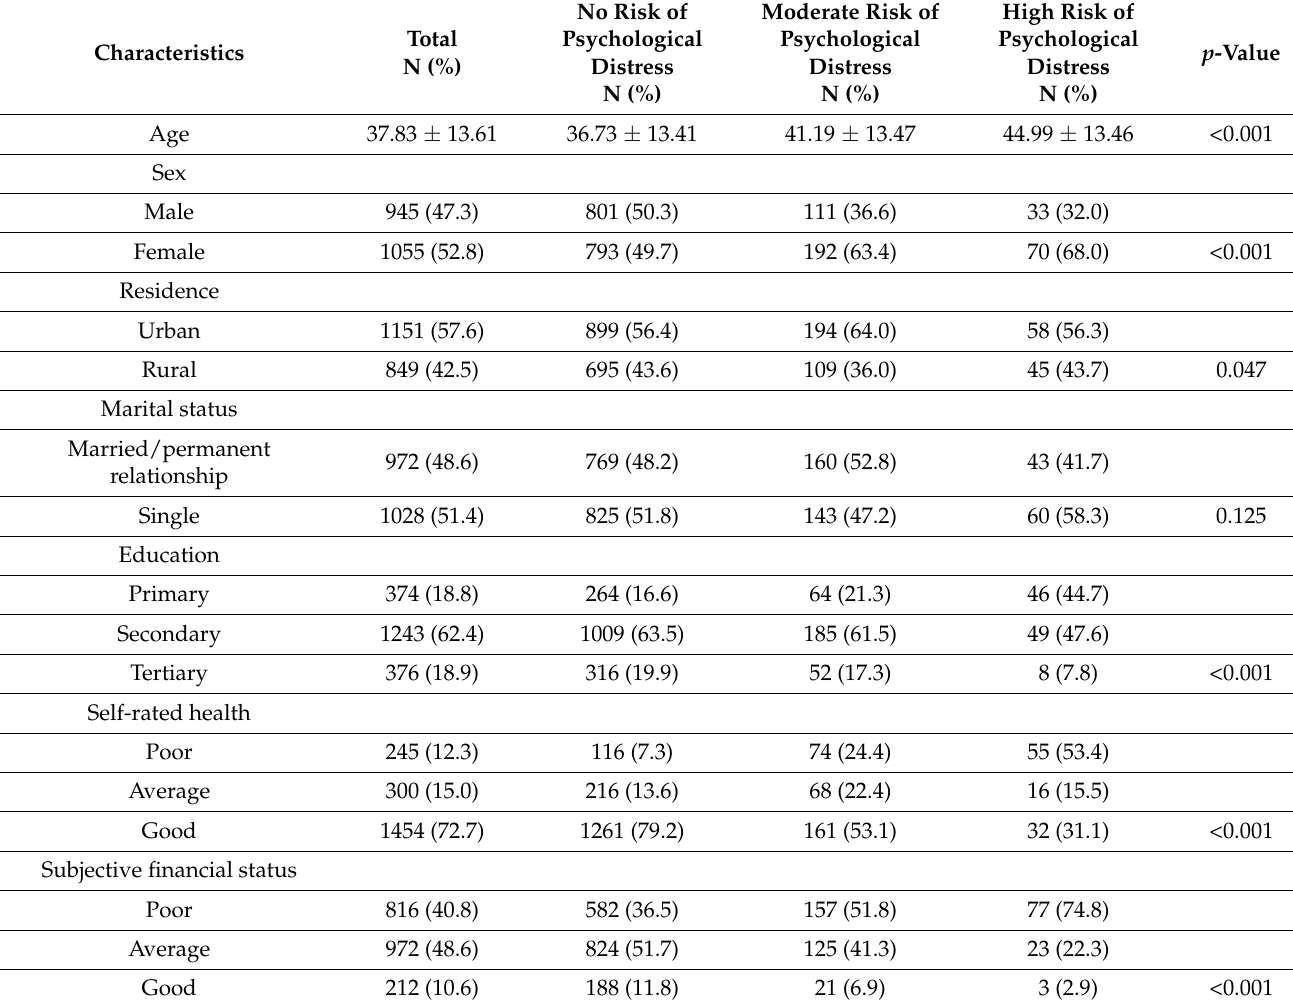
Table 1. Characteristics of the